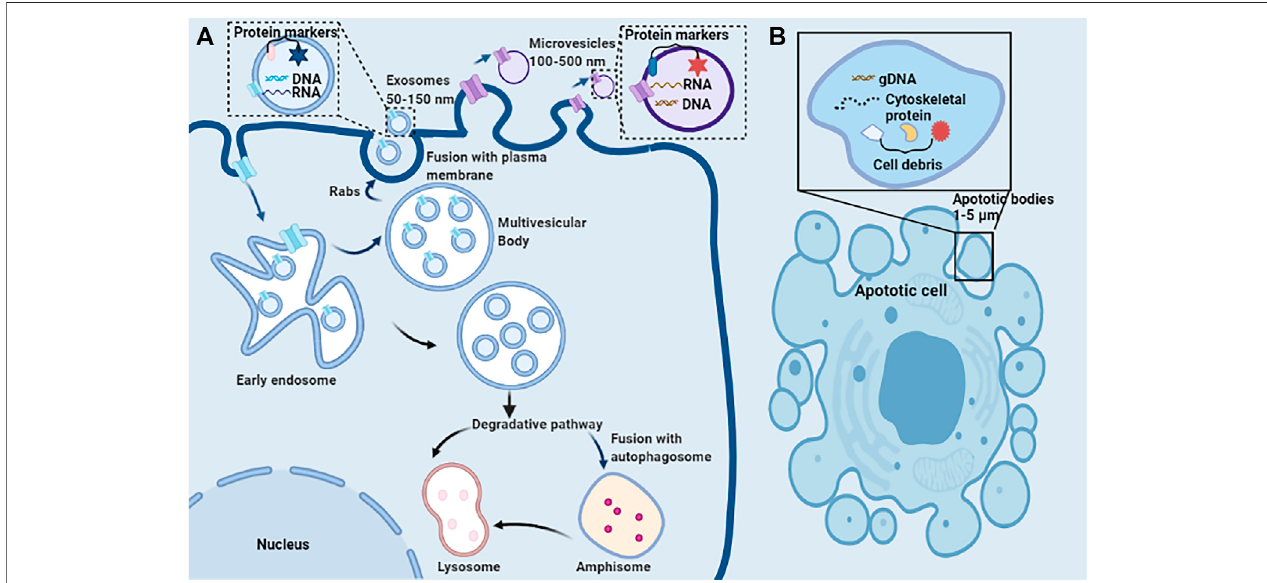
FIGURE2| Schematicrepresentationoftherelease,structure,andcompositionofextracellularvesicles. (A) Directsproutingandsplittingoftheplasmamembrane deformed into microvesicles (100 – 500 nm in diameter). In early endosomes, proteins are sequestered in intraluminal vesicles of the larger MVBs. The inward budding of endosomal membranes forms intraluminal vesicles of MVBs. MVBs bud inward and then fuse with the plasma membrane results in the release of their enclosed exosomes (~50 – 150 nm) from the cell into the microenvironment. Due to its biophysical properties, MVBs can be degraded by entering the lysosome directly or fusing with autophagosome and then entering the lysosome. (B) Apoptotic or dying cells shrink to produce apoptotic bodies (ABs) (1,000 – 5,000 nm). ABs are condensed remnants of the apoptotic cell, with nuclear and cytoplasmic components.